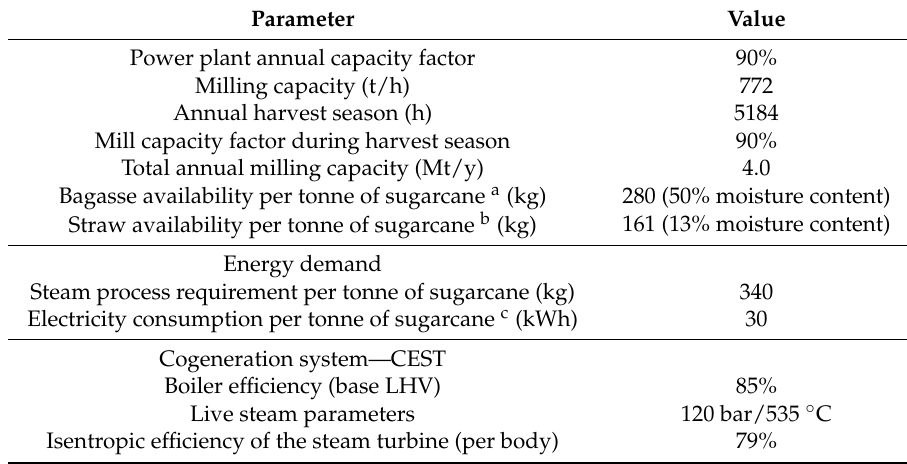
Table 1. Characteristics of the reference mill and the power